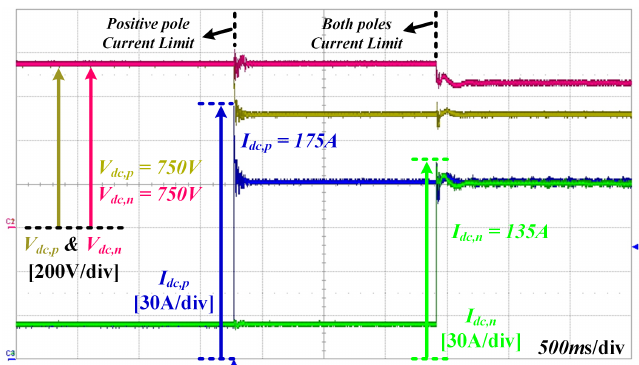
Figure 19. Experimental results of current limit operation in short-circuit condition of both poles.